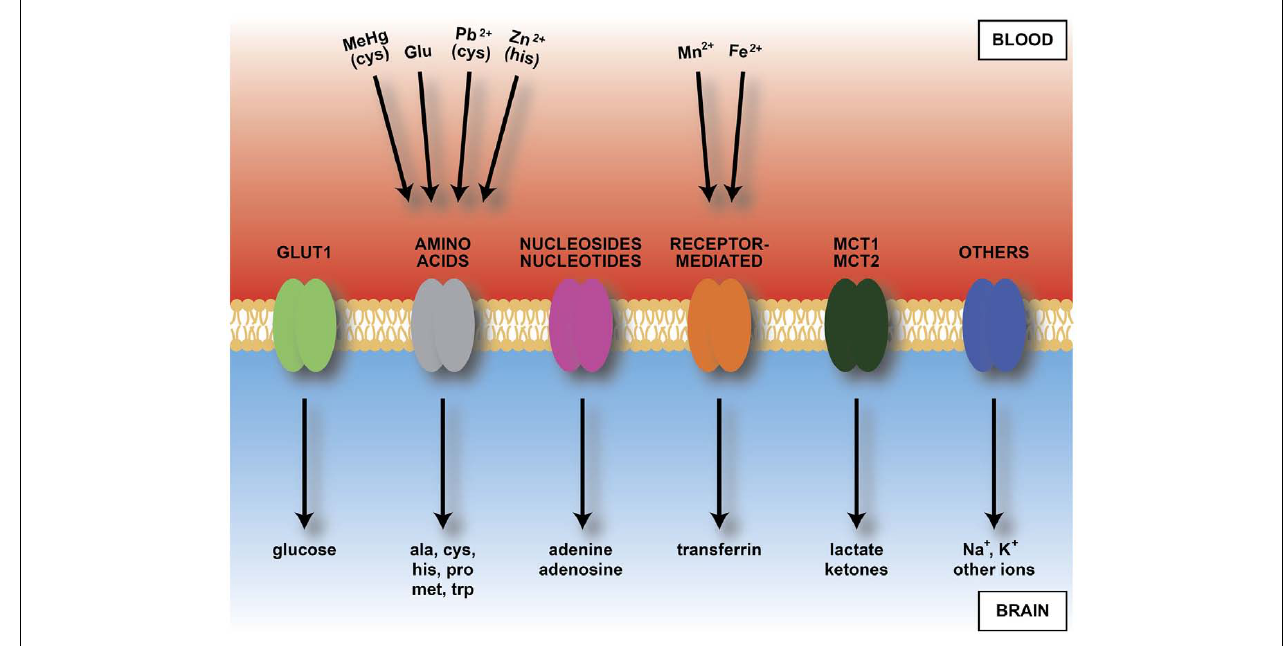
developing brain, including those up-regulated compared to adult. Abbreviations: ala, alanine; cys, cysteine; Fe 2 + , iron; Glu, glutamate; his, histidine; MCT, monocarboxylate transporter; MeHg, methyl mercury; met, methionine; Mn 2 + , manganese; Pb 2 + , lead; pro, proline; trp, tryptophan; Zn 2 + ,